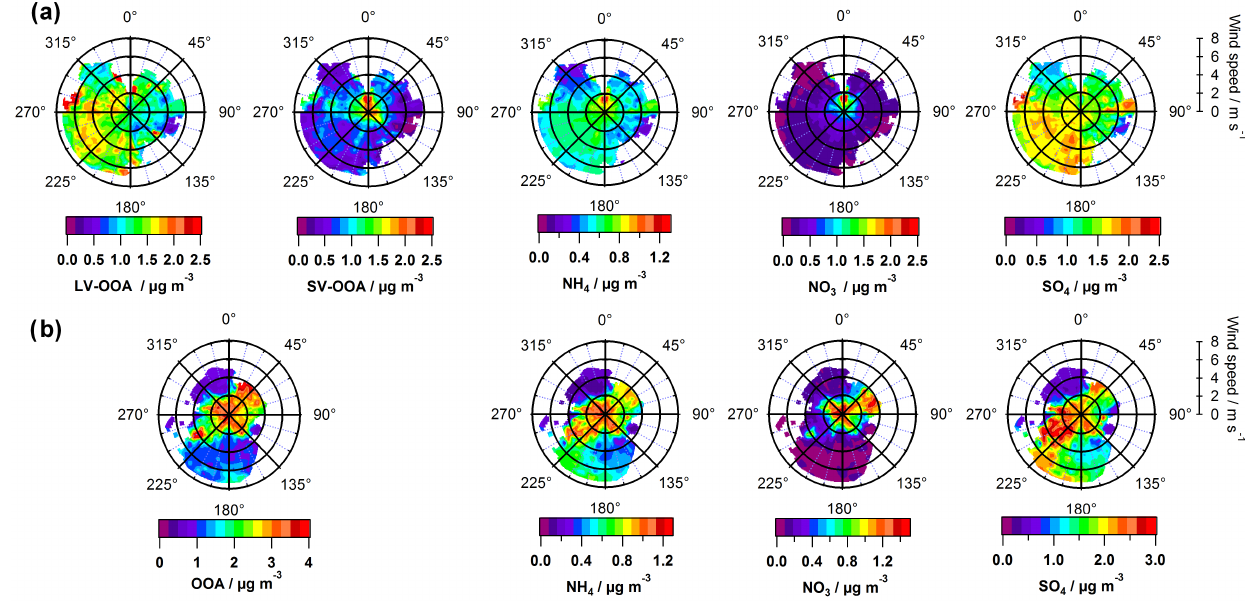
Figure 8. Polar plots of (a) submicron LV-OOA, SV-OOA, NH 4 , NO 3 and SO 4 concentration (colour coded) obtained from DIAPASON2014 measurements and (b) submicron OOA, NH 4 , NO 3 and SO 4 concentration obtained from DIAPASON2013 measurements as a function of local wind direction ( ◦ ) and speed (ms − 1 ) .